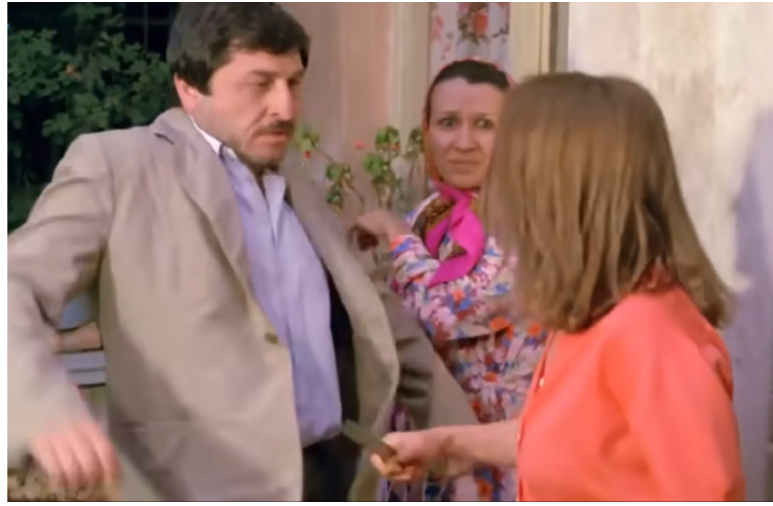
Figure 1: Aygül (Hale Soygazi) attacks her brother-in-law and sister-in-law